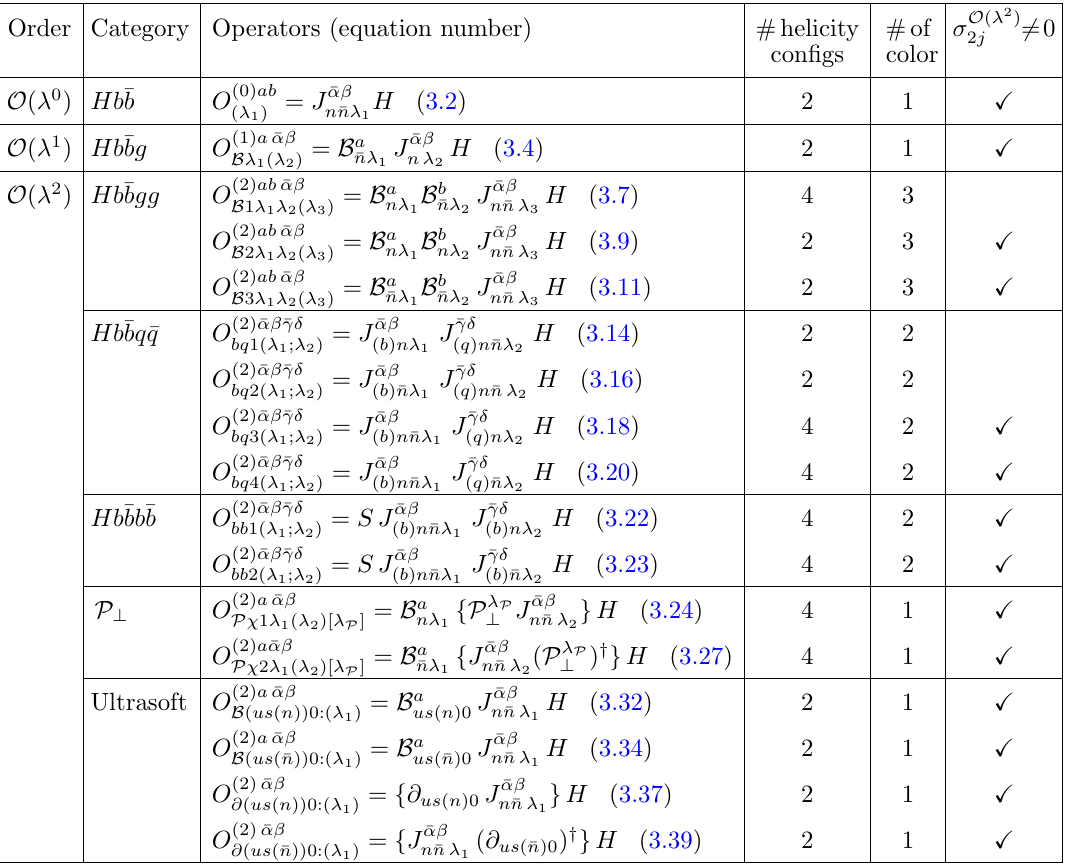
Table 2 . Basis of hard scattering operators for H